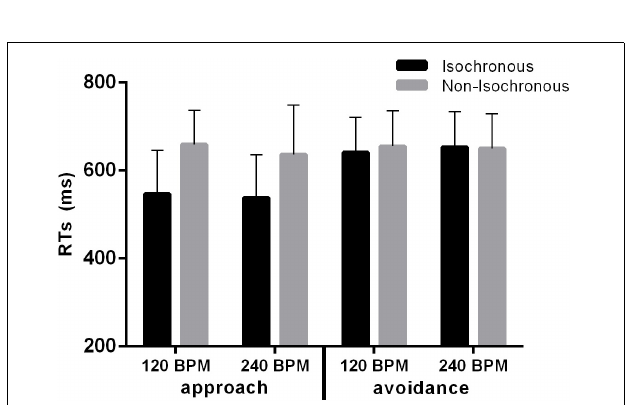
FIGURE 3 | Results of the VAAST task showing RTs for correct responses according to the body movement (approach/avoidance), auditory rhythmic stimulation (isochronous/non-isocrhonous) and tempo (120/240 BPM). Analysis revealed significant main effects of body movement and rhythm, as well as a significant interaction body movement × rhythm, thus indicating that participants were faster in approach (vs. avoidance) response following an isochronous (vs. non-isochronous) auditory stimulation.